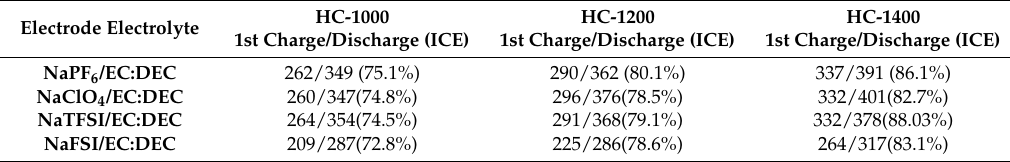
Figure 5. Rate and cycle performance. ( a ) Discharge/charge curves at the different rate from 0.1–1 C; and ( b ) cycle performance of HC-1400 with NaTFSI/EC:DEC at a current rate of 0.5 C. Table 1. Initial efficiency of hard carbon as anode with different electrolytes.